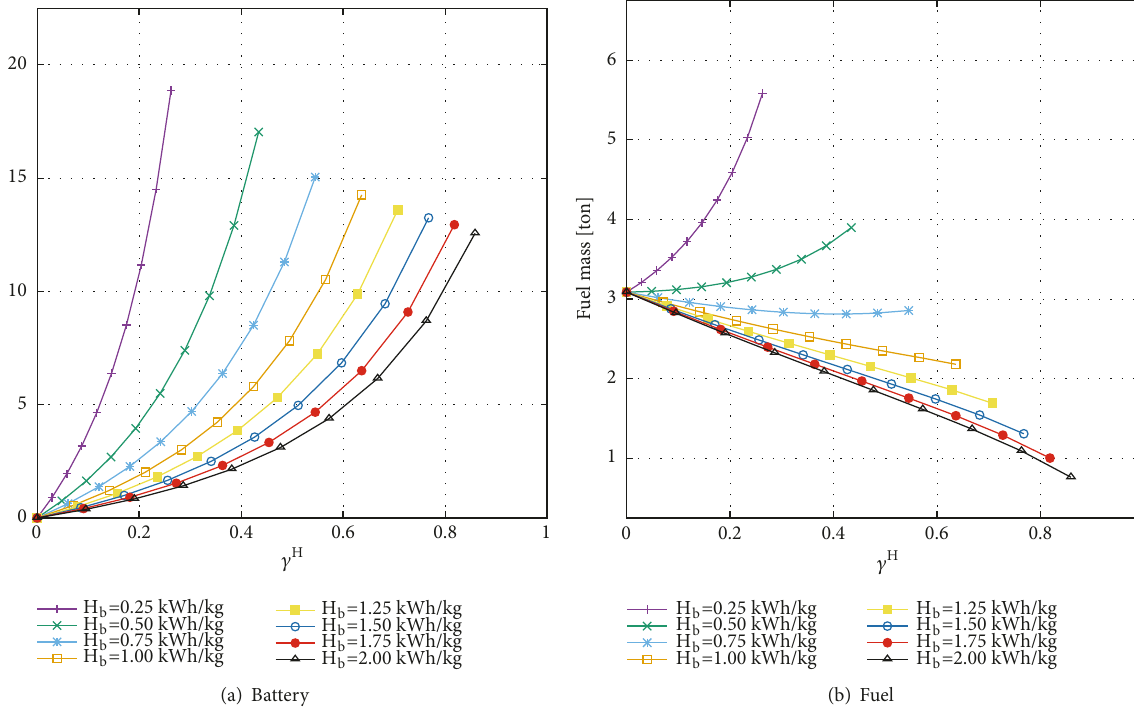
Figure 7: Battery-pack mass (a) and fuel mass (b) as functions of 𝛾 𝐻 related to the regional BWB aircraft, with the battery specific energy as